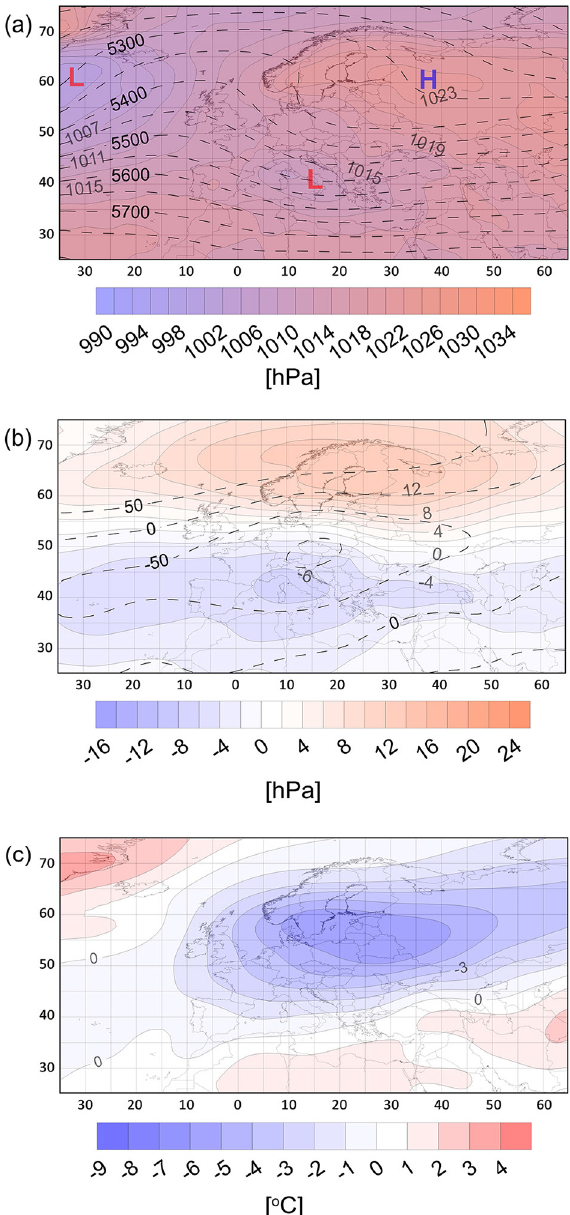
Fig. 4. Mean SLP [in hPa] (colour scale) and z500 hPa [in gpm] (dotted line) (A) anomalies of SLP [in hPa] (colour scale) and z500 hPa [in m] (dotted line) (B) and anomalies of T850 [in °C] (C) for days with very strong and extreme cold stress. SLP, sea level